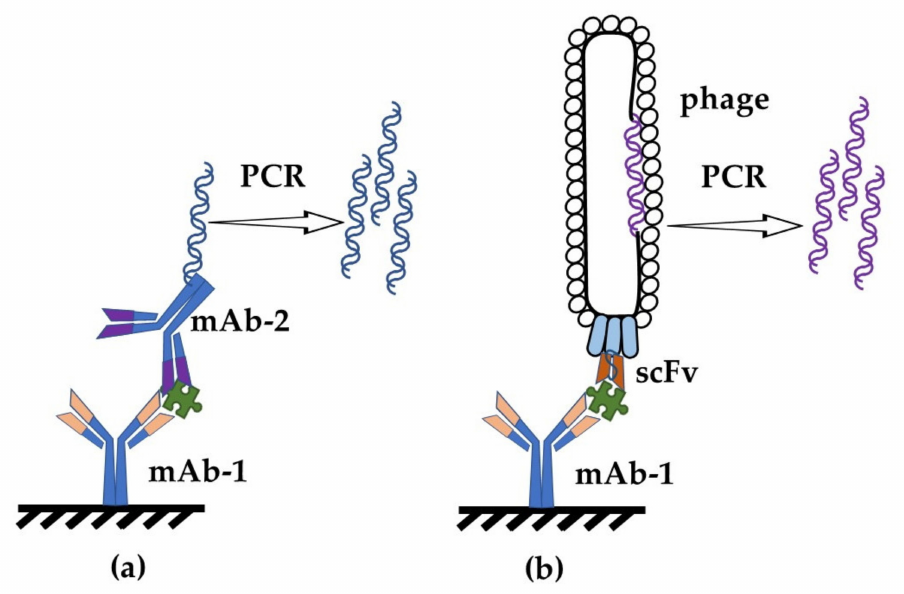
Figure 2. Schematic representation of immuno-PCR ( a ) and phage-display-mediated immuno-PCR ( b ) in antigen